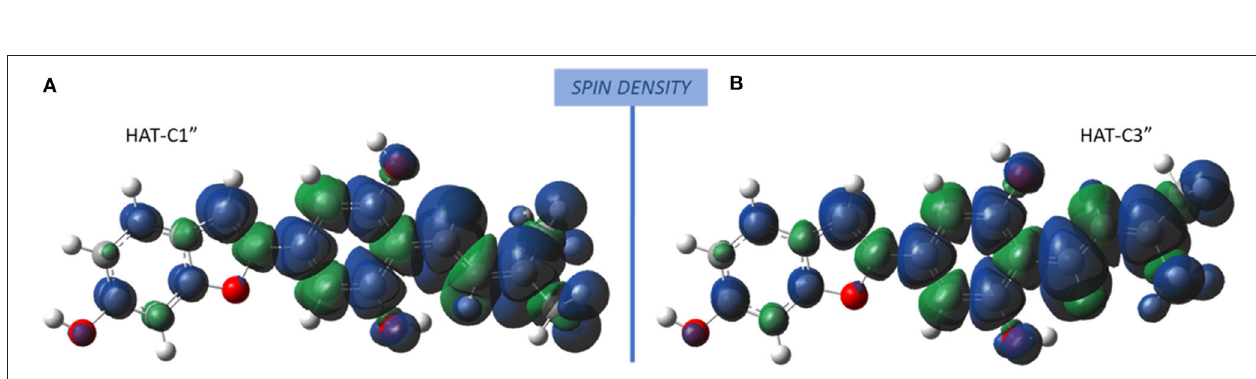
Frontiers in Chemistry |